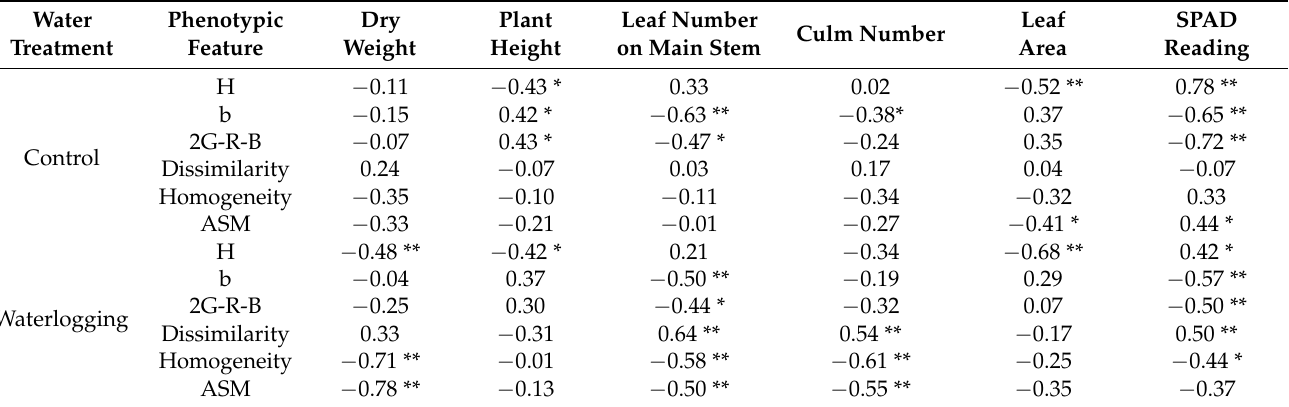
Table 7. Correlation coefficients of selected phenotypic features extracted from images of the top view with agronomic traits under control and waterlogging conditions.